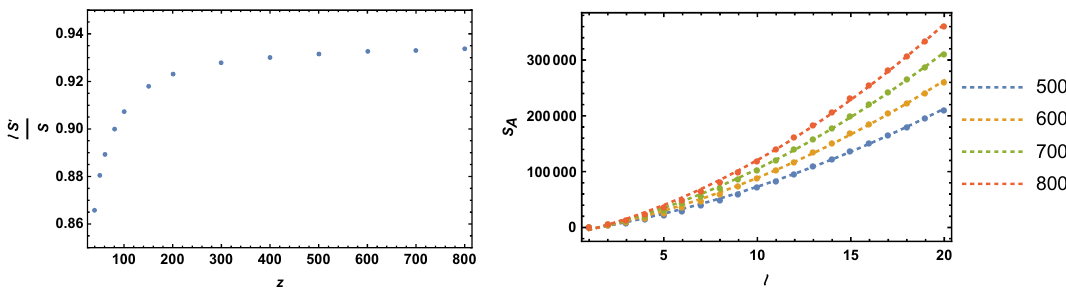
Figure 11 . Left : ‘S 0 as a function of z for a square with enclosing 49 sites ( ‘ = 7). For large S values of z this quantity approaches to a constant value exhibiting volume law behavior. right : (cid:12)tting data for EE as a function of ‘ for di(cid:11)erent values of z . Here we consider Dirichlet boundary condition for a massless scalar with N x = N y = 250.